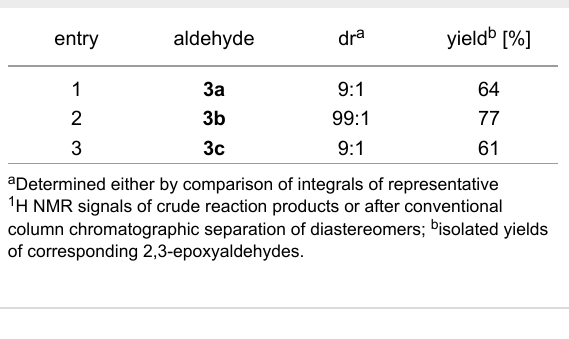
Table 1: Epoxidation of aldehydes 3a–c